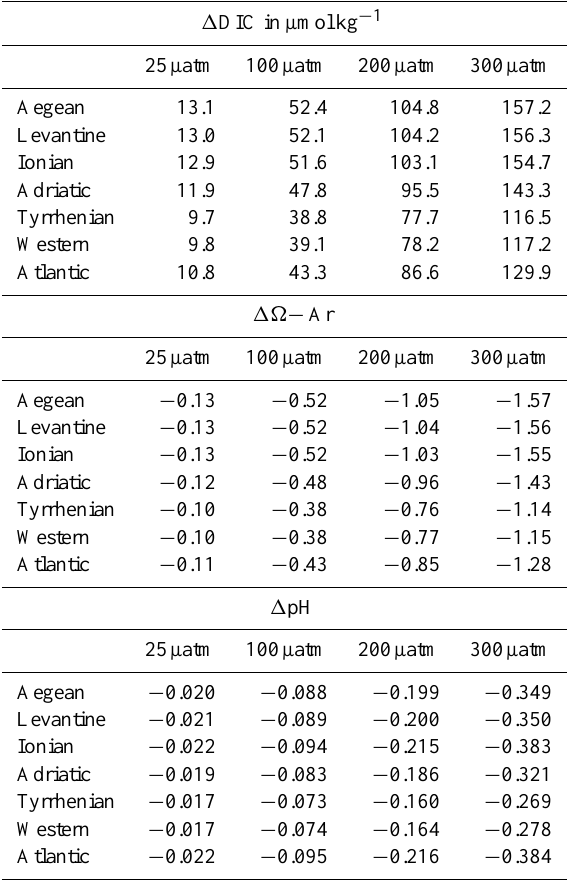
(both in the southern Aegean Sea). In the upper 100 dbars high salinity identifies LSW (Levantine Surface Water) en- tering the Aegean Sea through the eastern Cretan arc straits (Fig. 11a). This LSW was also identified by the high- est pH25T values measured in the M84/3 cruise ( > 8.01, Fig. 12h) and also high TA and DIC values ( ≈ 2620 and ≈ 2280 µmol kg − 1 , respectively, Fig. 12a and d). At inter- mediate levels, 100 to 250 dbars, CIW (Cretan Intermedi- ate Water) presented the highest TA values for the M84/3 cruise ( ≈ 2645 µmol kg − 1 , Fig. 12a and d). Deep layers be- low 2500 dbars were occupied by CDW (Cretan Deep Wa- ter), warm, salty and very dense (Fig. 11a), also identified by the distinct SiO 2 -salinity relation (Fig. 11c), practically con- stant DIC ( ≈ 2320 µmol kg − 1 ) and TA ( ≈ 2630 µmol kg − 1 ) values vs. SiO 2 (Fig. 12b and